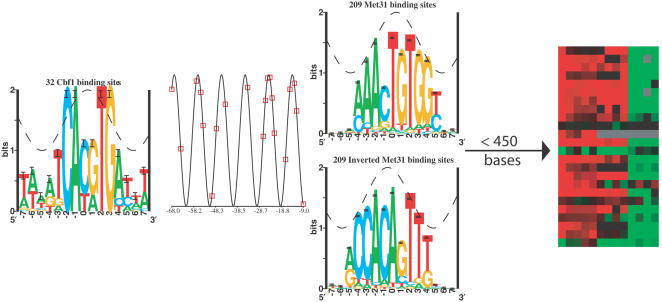
The Met4 activation model based on our analysis.We summarize here the spacing, ordering, and orientation constraints we used to define functional Met4 binding sites. Since Met31 can bind with either orientation, we show logos for both Met31 orientations. The distances between each set of Cbf1 and Met31 sites were plotted with red boxes on a cosine wave for 23 high-ranking genes to show helical preferences. The arrow represents the translational start, and the allowed distance between the Met4 stabilization complex and the translational start is written above it. The expression data on the right is what was predicted by this model, and is described in Fig. 6.